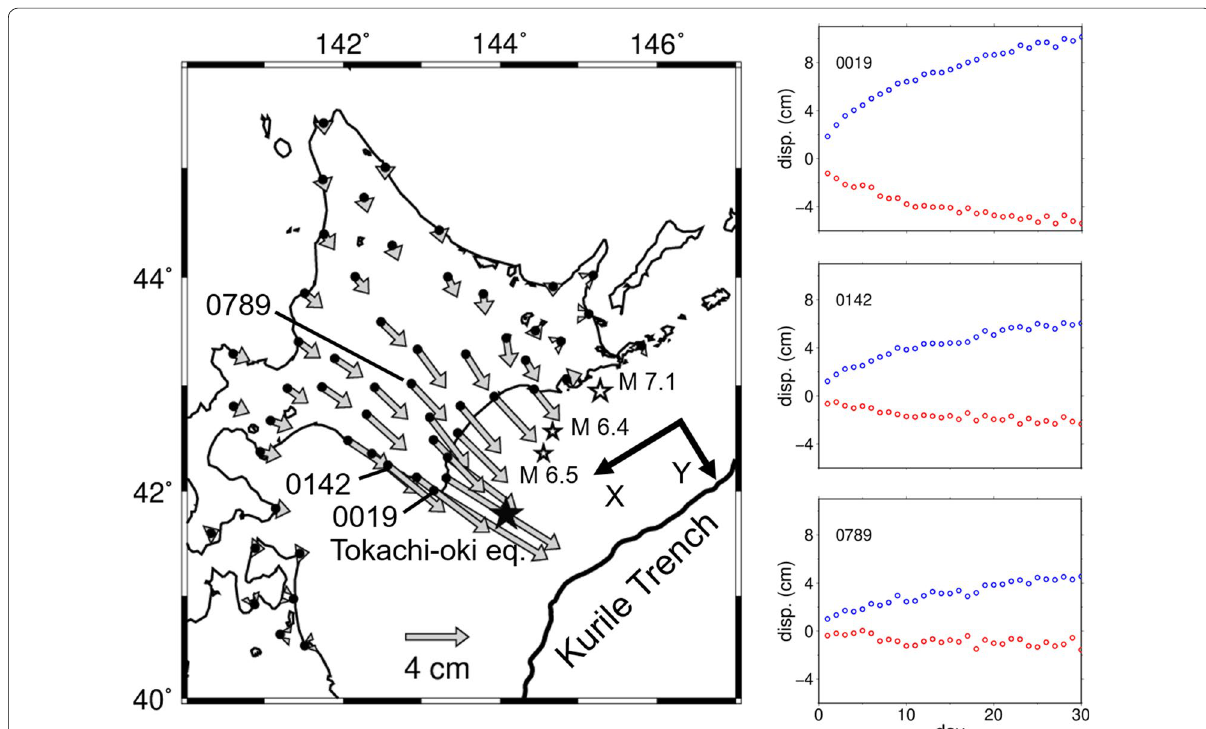
Fig. 1 Observed displacement vectors and GNSS time series. The left panel shows the observed cumulative displacement for 15 days following the 2003 Tokachi-oki earthquake. Black and white stars indicate the epicenters of the mainshock and three aftershocks, which are the M 7.1 2004 Kushiro-oki earthquake and the two M 6 class earthquakes occurred within 15 days following the mainshock. The coseismic steps for the two M 6 class earthquakes have been removed. The right panels show the examples of the GNSS time series at three stations for 30 days. The time series for the first 15 days are used for assimilation, while those for the later 15 days are used for testing the prediction skill of the developed method. Red and blue circles indicate the cumulative displacement in trench-parallel (X) and trench-perpendicular (Y) directions, respectively. The black dots show the locations of the GEONET stations used in this